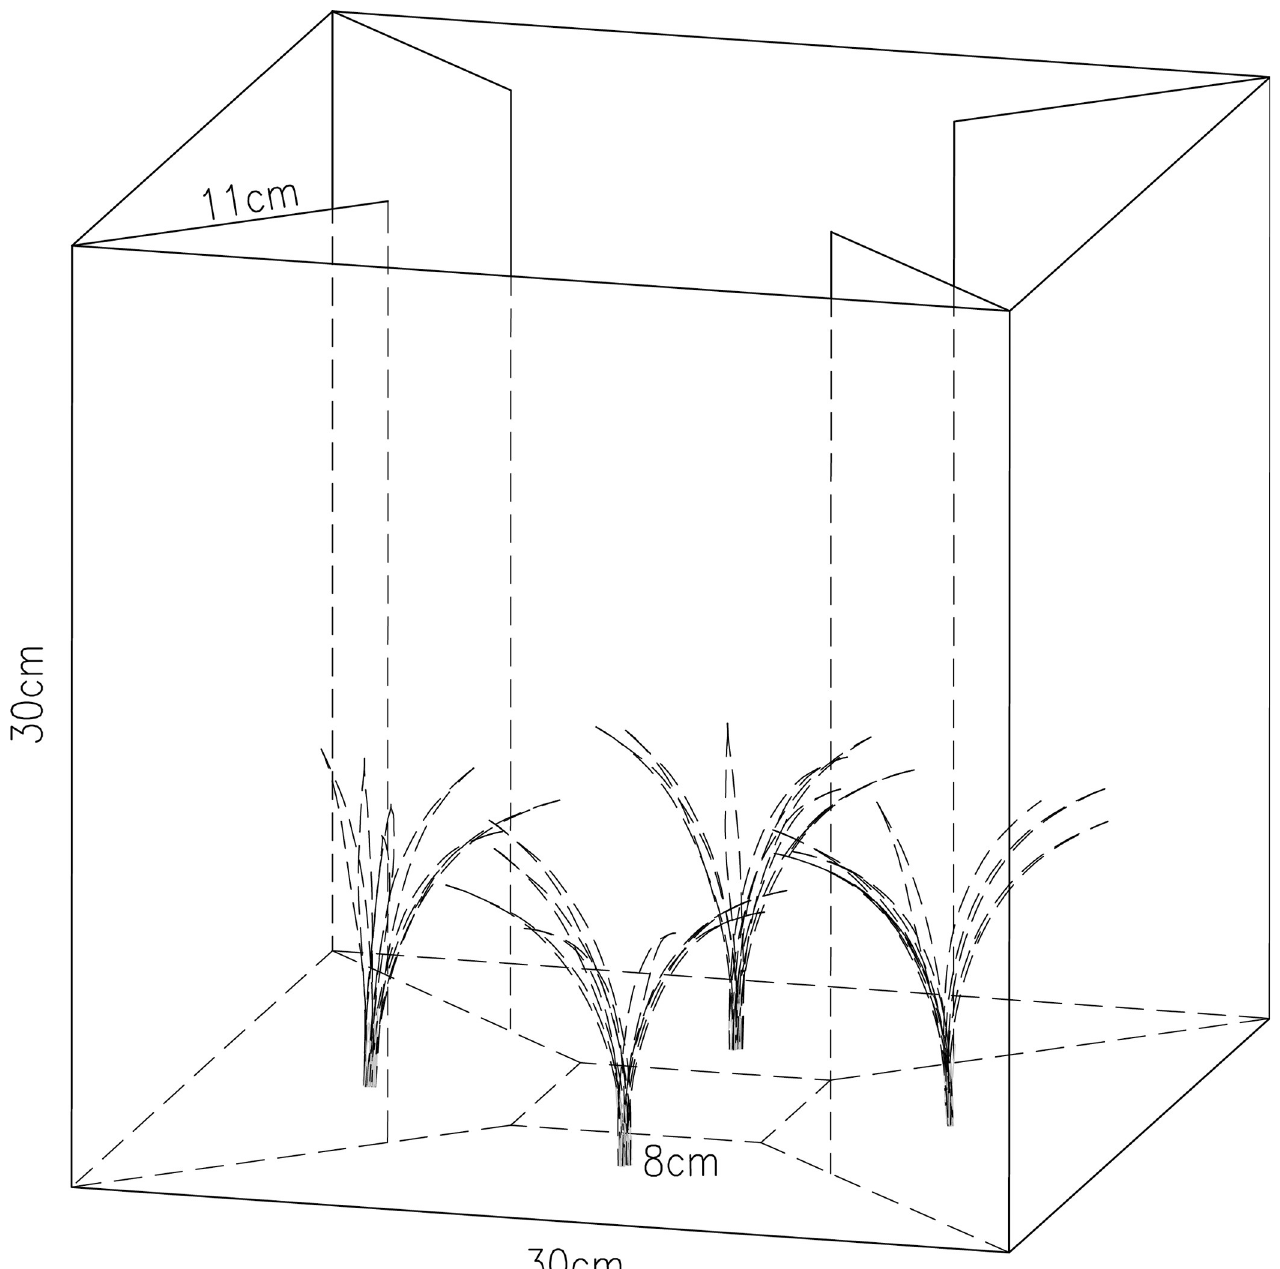
Fig 2. Device of the colour choice tests with Bradysia odoriphaga . Scheme of the device of colour choice test, which was designed as a cube (edge length = 30cm). In the middle of cube was small square (edge length = 8cm) used as a decision area. The chambers were separated by cardboard. All four differently coloured chambers contained a mimic chive